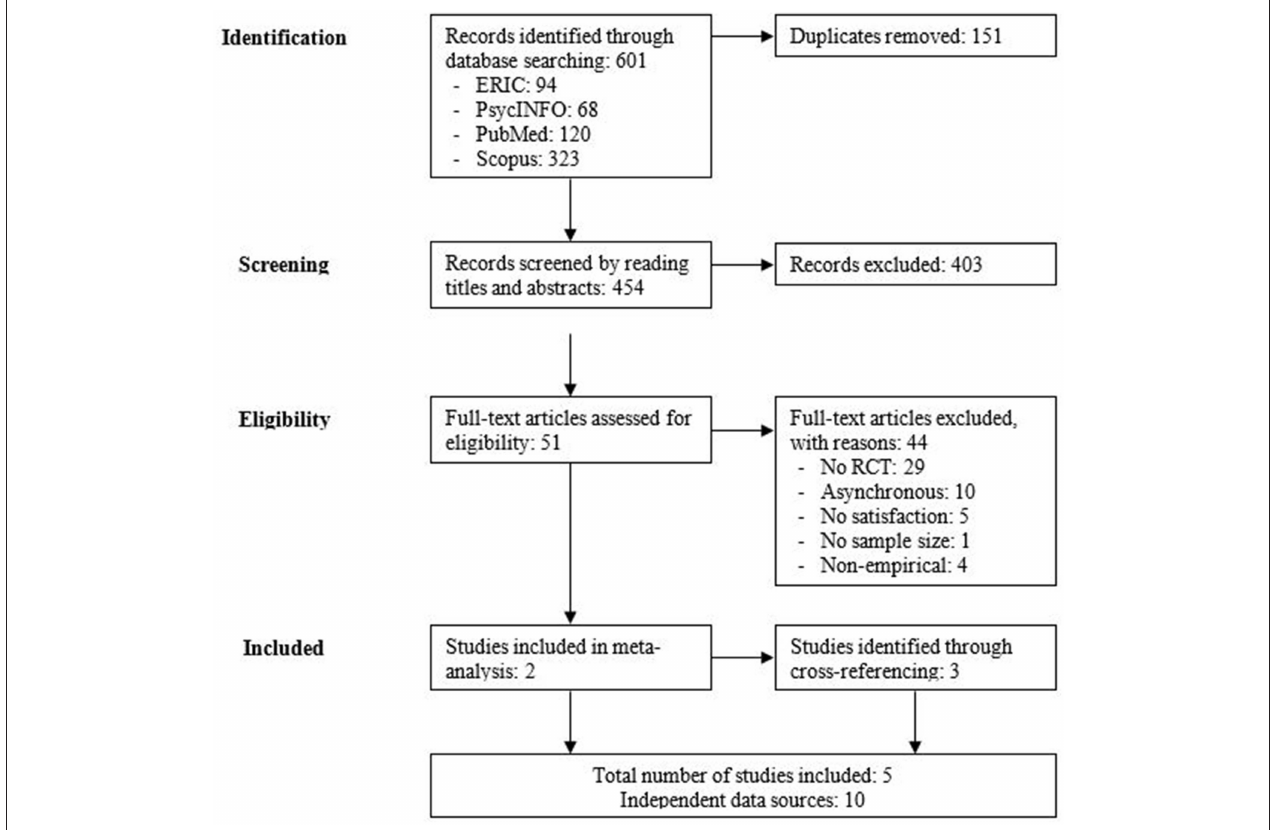
FIGURE 2 | Study selection flow